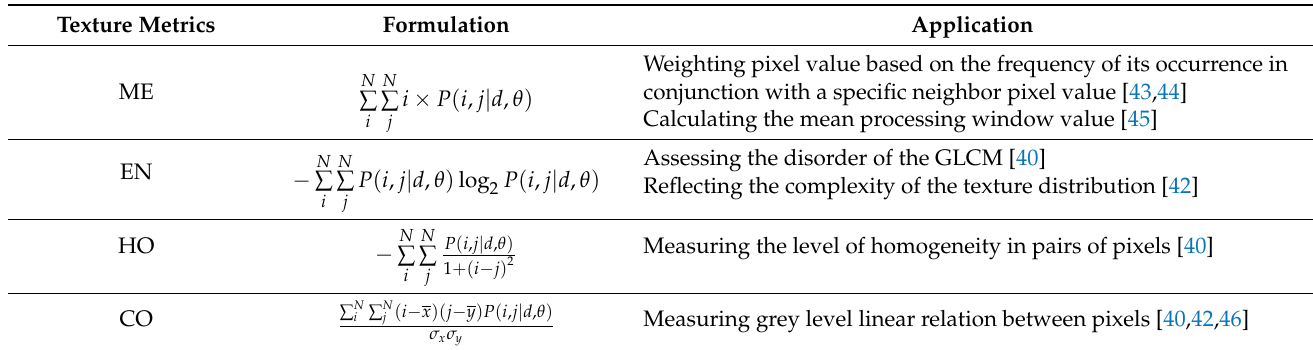
Table 2. Texture metrics